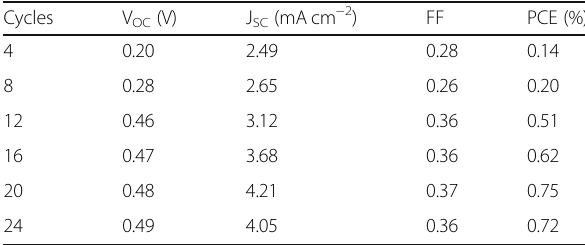
Table 1 Photovoltaic parameters obtained from the J-V curves of QDSSCs using TiO 2 /CIS films prepared with different cycles as